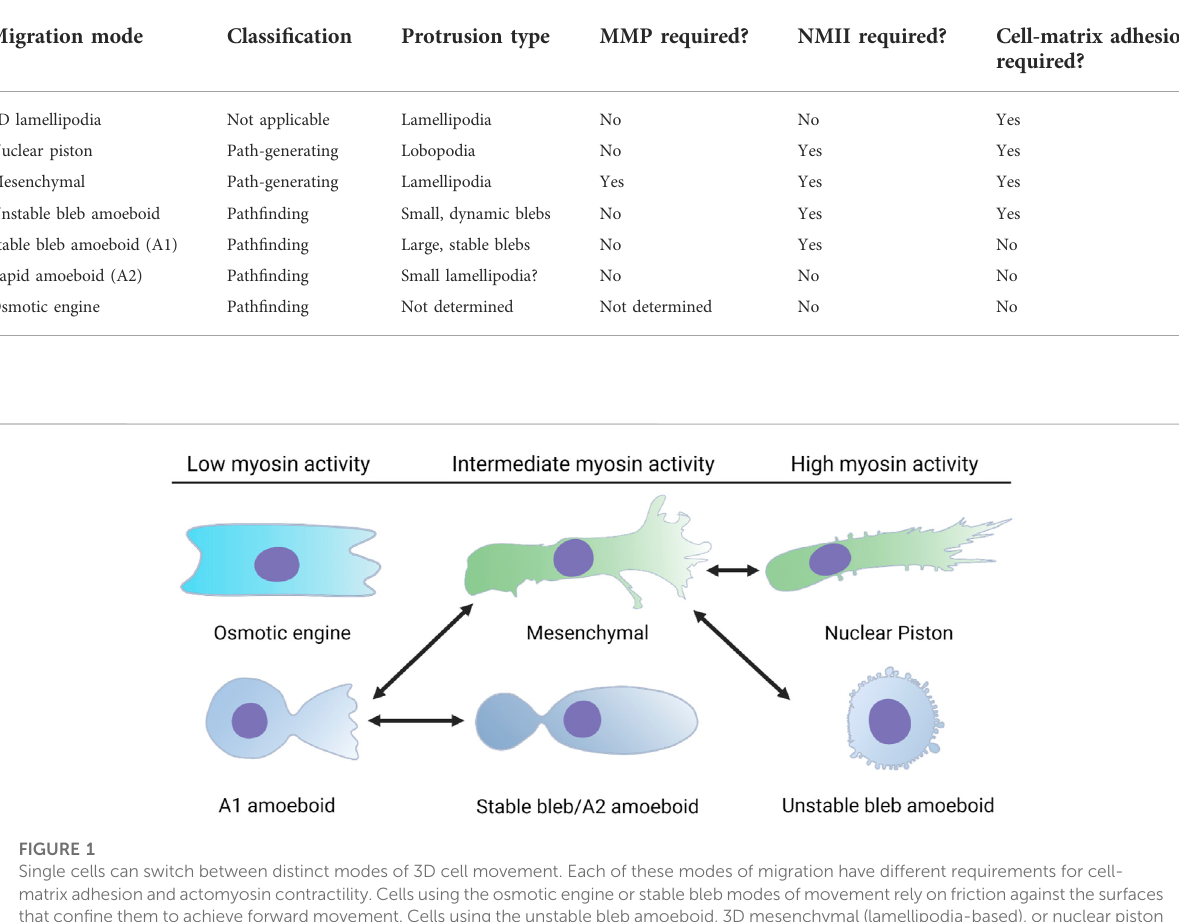
TABLE 1 Modes of single cell migration.